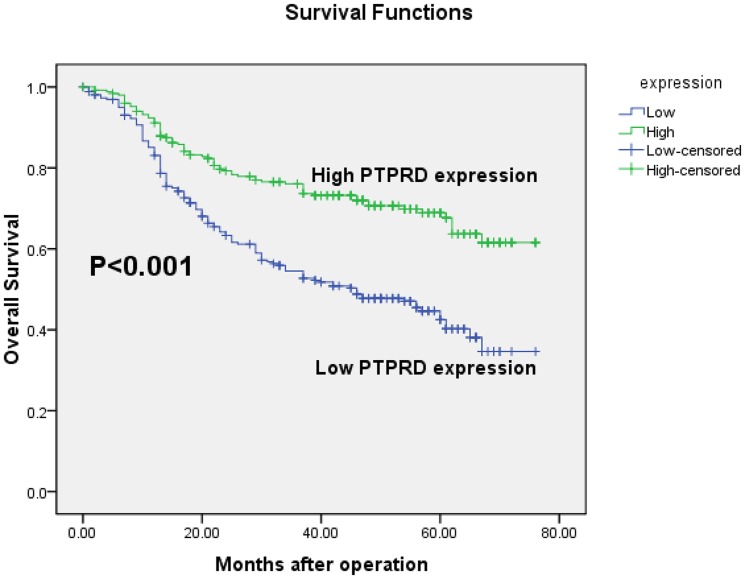
Kaplan-Meier survival curves of gastric adenocarcinoma patients (n = 513) after gastrectomy.The survival rate of patients in PTPRD-high group was significantly higher than that of the patients in the PTPRD-low group (log-rank test, P<0.001).